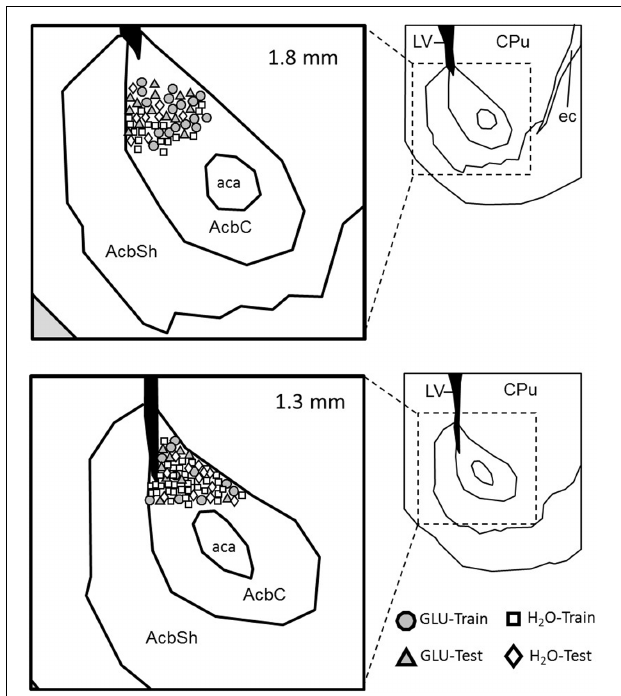
FIGURE 7 | Locations of recorded pMSNs. Estimated positions of the recorded pMSNs in each condition (Training or Test) in each group (GLU and H 2 O) in coronal sections. Each inset in the right shows a low-magnified view of the corresponding section. The value on each section indicates the distance from the bregma. AcbC, nucleus accumbens core; AcbS, nucleus accumbens shell; aca, anterior commissure anterior part; CPu, caudate putamen; ec, external